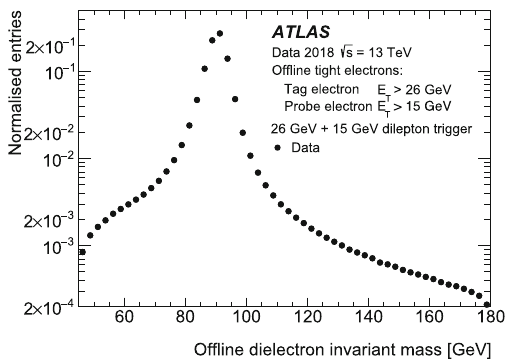
Fig. 26 The uncorrected offline dilepton invariant mass in events from the dilepton performance trigger that pass the analysis selection. For the performancetriggers,theRoIsusedbythefastandprecisiontrackingare the same and so the offline dilepton candidates chosen for the analysis of the fast and precision tracking are